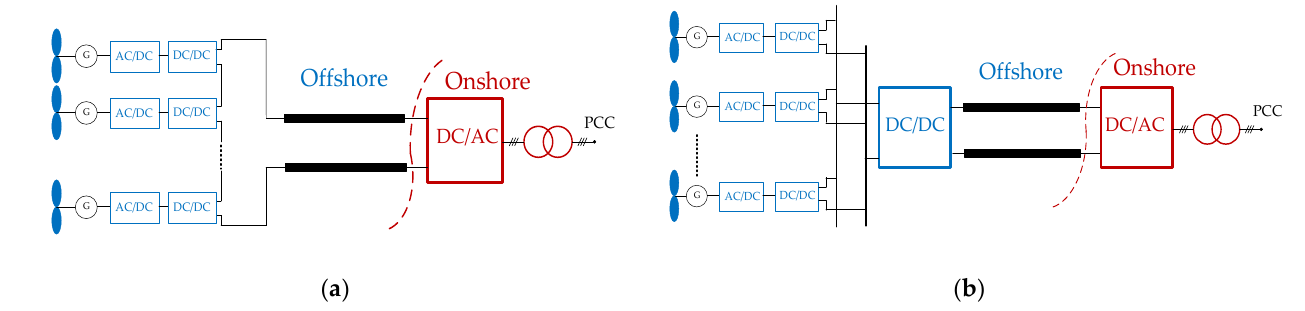
Figure 1. DC collection grids of OWF: ( a ) DC series-connection OWF; ( b ) DC parallel-connection OWF.